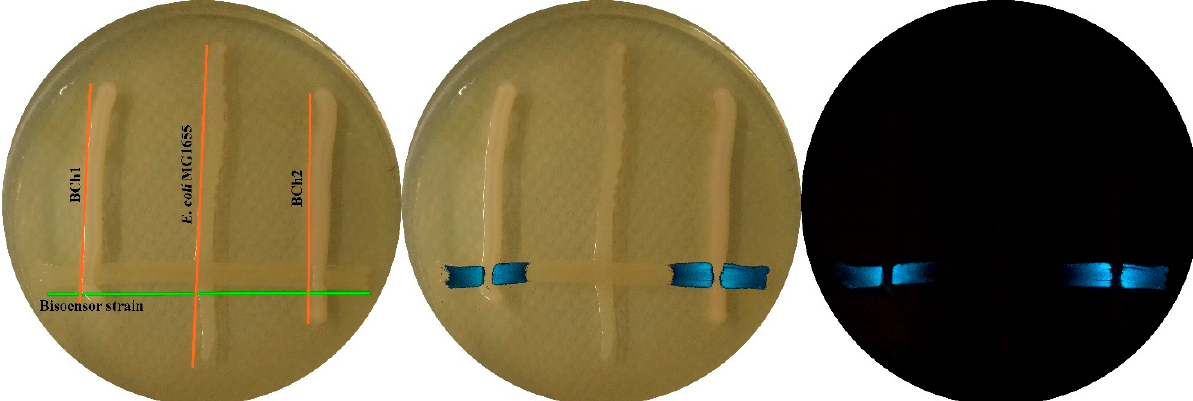
Figure 5. Photographs of Petri dishes with isolated strains and biosensor cells. Vertical line— E. coli MG1655 (as negative control) and isolated environmental bacterial strains BCh1 and BCh2; horizontal—biosensor cells of E. coli MG1655 pVFR1 pSVRAF sensitive to 3OC6-HSL. On the left—photograph under ambient light with annotation; on the right—in the dark, in the image in the middle an overlapping induced luminescence on photographs of Petri dishes under ambient light is shown.